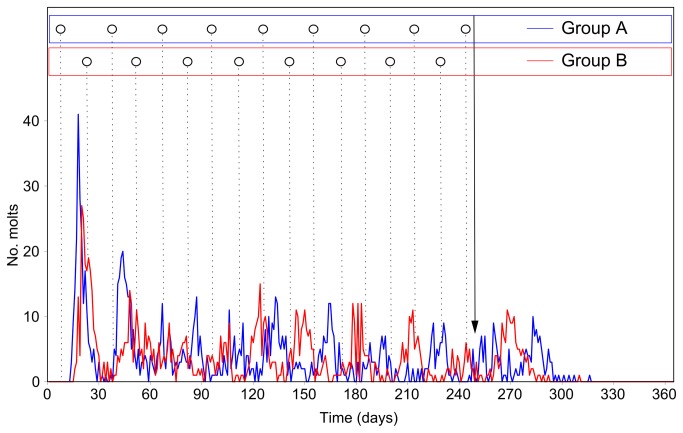
Daily molt frequencies over a one year period under artificial moonlight cycles (experiment 2).Open circles indicate full moons; day 1 = March 30, 2012; day 365 = March 29, 2013. Group A (blue): artificial cycle in phase with the natural lunar cycle; Group B (red): artificial cycle phase-shifted by half the lunar period. Arrow: Termination of moonlight regimes on December 03 (Day 249).